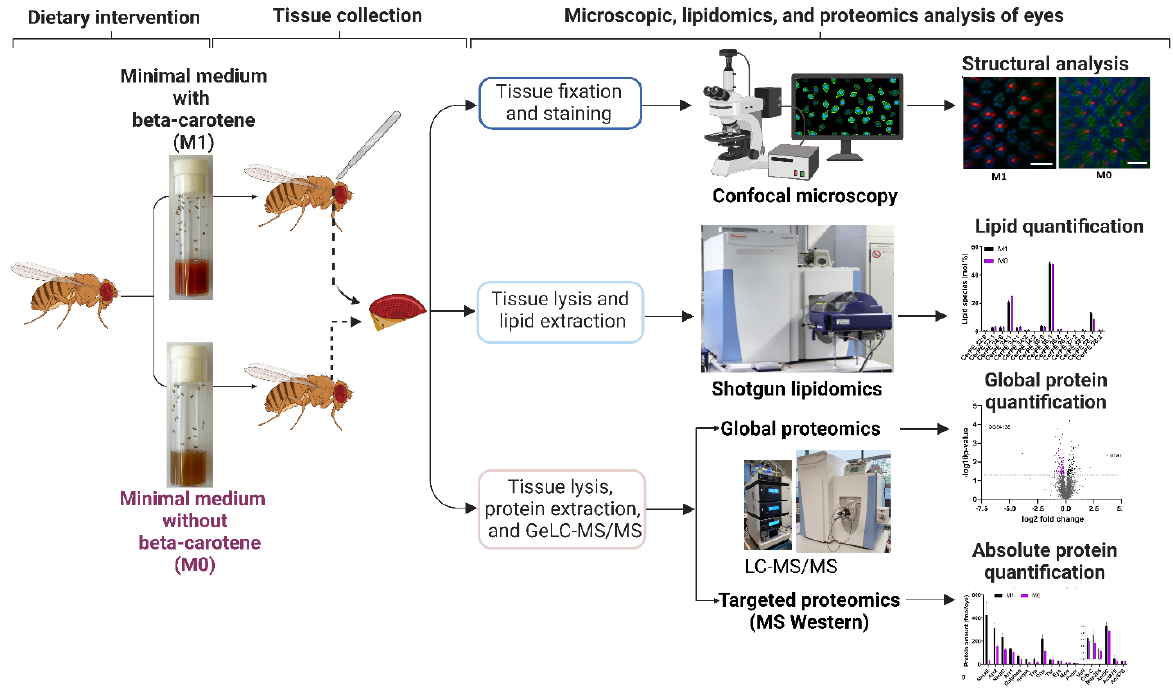
Figure 1. Experimental workflow to analyze the impacts of vitamin A deficiency on the morphology, the lipidome, and the proteome of the Drosophila eye. Schematics were created with BioRender. For details, see text.